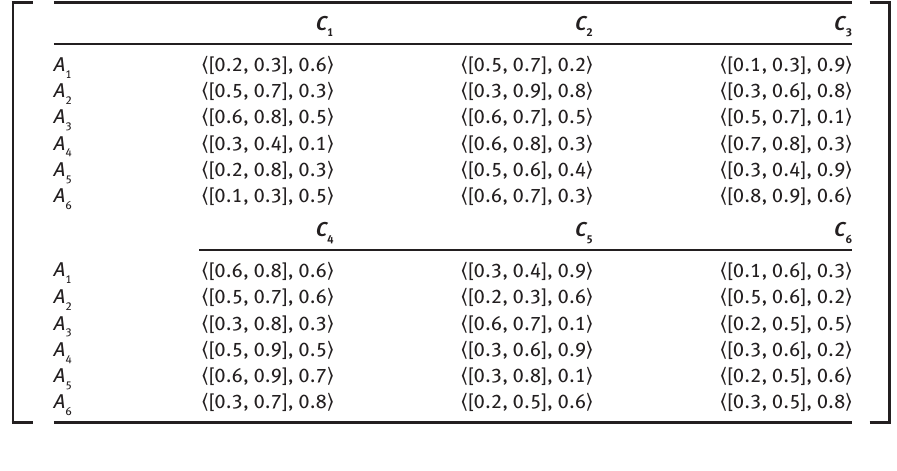
Table 4: Characterization of the Investments of Expert